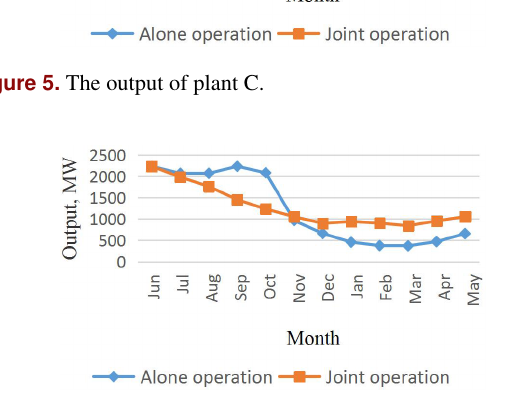
Figure 4. The output of plant B.